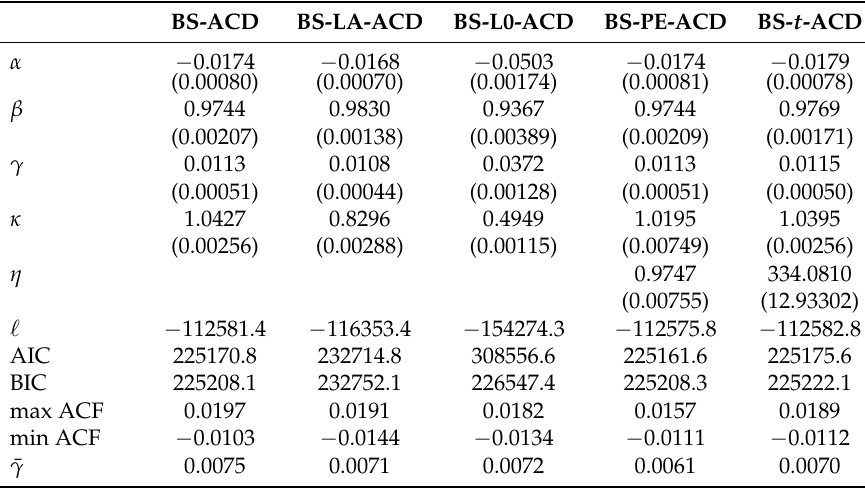
Table 5. Estimation results based on the GBS-ACD models for JNJ trade